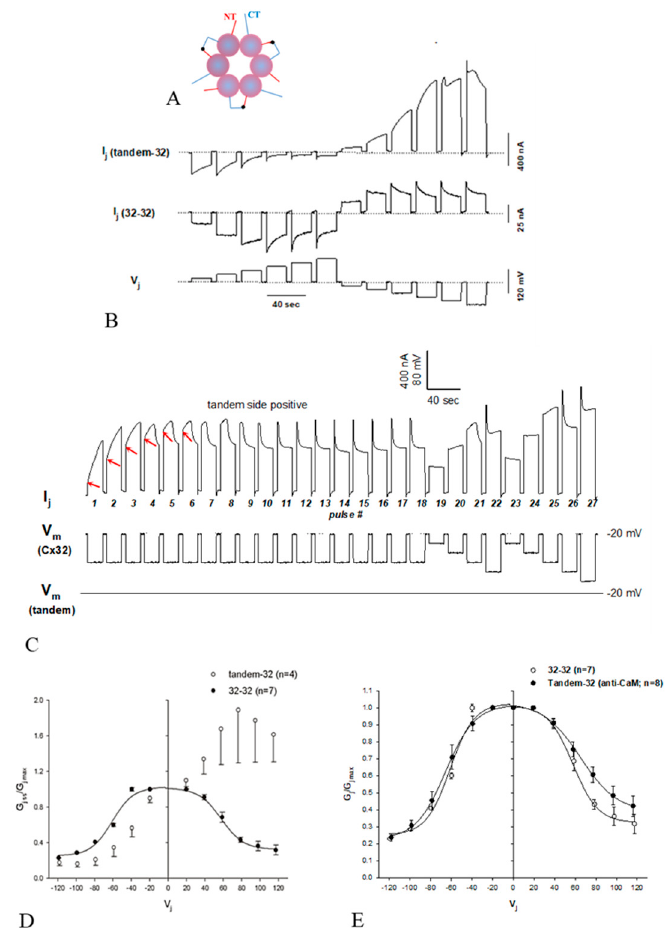
Figure 7. Ij / Vj records of Xenopus oocyte pairs expressing either homotypic Cx32 channels (32–32) or heterotypic tandem-32 channels ( A , B ). While 32–32 channels manifest a characteristic Ij sensitivity to Vj ( B ), tandem-32 channels show an unusual behavior ( B ). With mutant side negative ( B , left), initial and final Ij gradually drop to very low values, while with mutant side positive ( B , right), Ij gradually increases to high values and only at Vj = 100–120 mV, a more typical Ij behavior appears. With repeated application of 60-mV Vj pulses (tandem side positive), 3 types of Ij behavior are observed: monophasic Ij increase ( C , pulses 1–3), biphasic Ij time-course ( C , pulses 4–9 and conventional Ij behavior ( C , pulses 10–18). Subsequent applications of the Vj protocol (tandem side positive) result in fairly normal Ij behaviors ( C , pulses 19–27). The asymmetric Ij-Vj behavior of tandem-32 channels is demonstrated in plots of normalized Gj versus Vj ( D ). Significantly, the asymmetrical Ij / Vj behavior is not observed following inhibition of CaM expression ( E ). ( B , C ) from [77]; ( D , E ) from